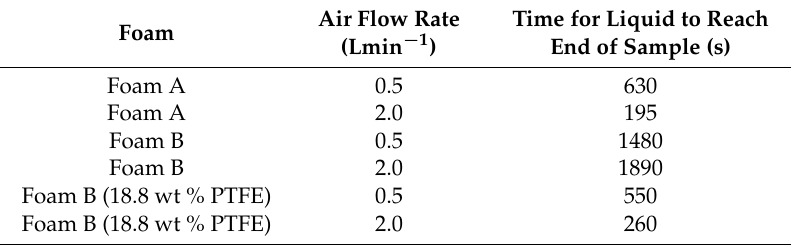
Table 2. Time for liquid water to reach the end of the foam sample after initially entering at 3.0 gh −